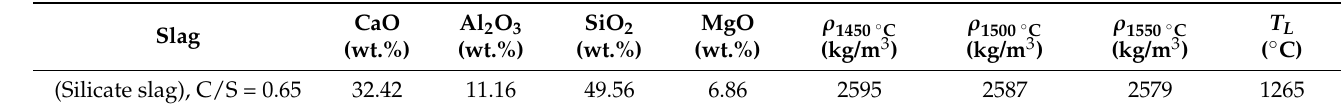
Table 1. Slag properties. ρ and T L denote the density and liquidus temperature, respectively.